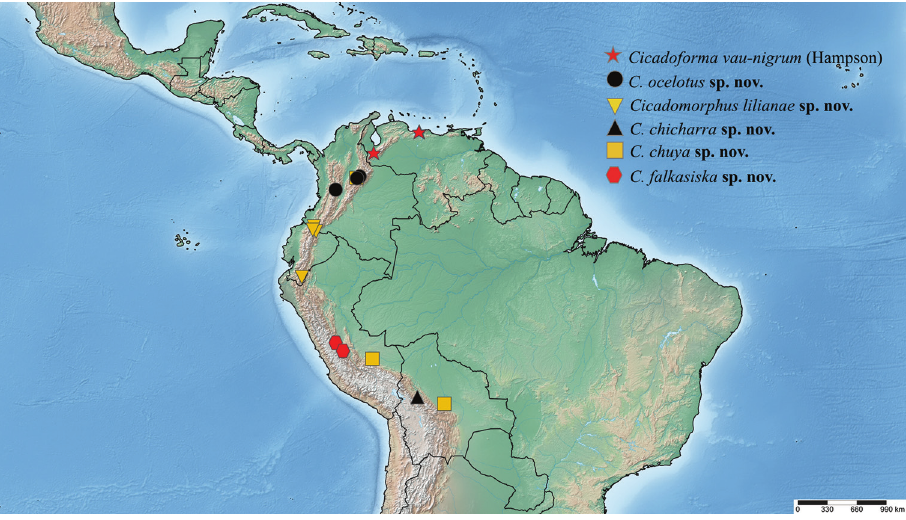
Figure 92. Distribution of examined specimens of the genera Cicadoforma and Cicadomorphus .